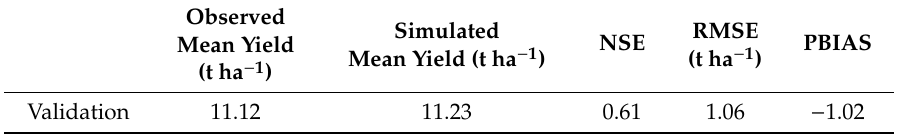
Table 5. Mean simulated and observed maize grain yield in tonnes per hectare (t ha − 1 ), Nash–Sutcli ff